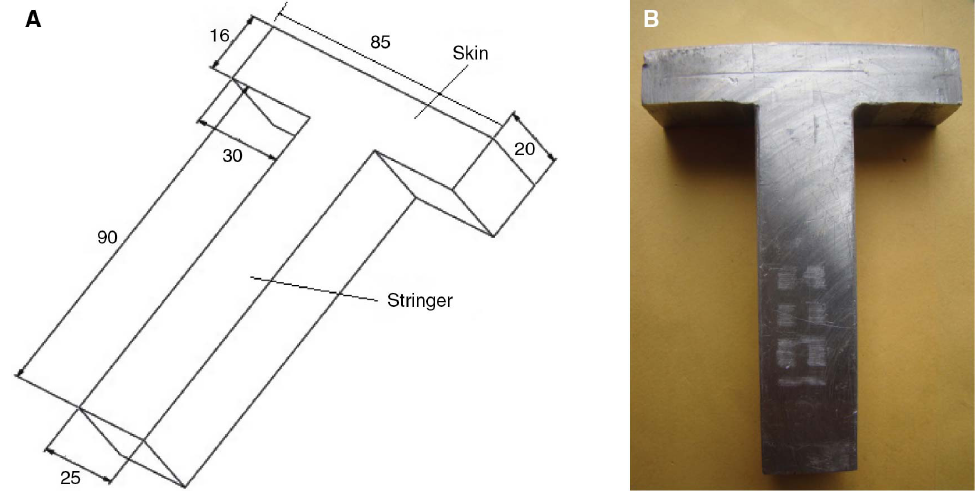
Figure 2: (A) Line diagram of the T-joint (all dimensions are in mm). (B) Photograph of the actual 19501 aluminiuun T- joint.